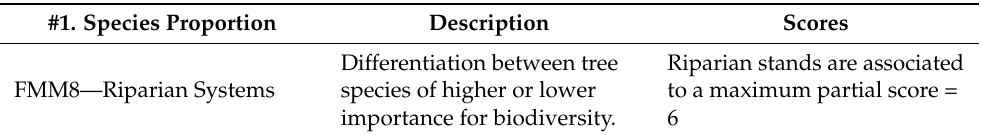
Table 8. Species proportion, description, minimum and maximum values used to define the FMM8 biodiversity score.